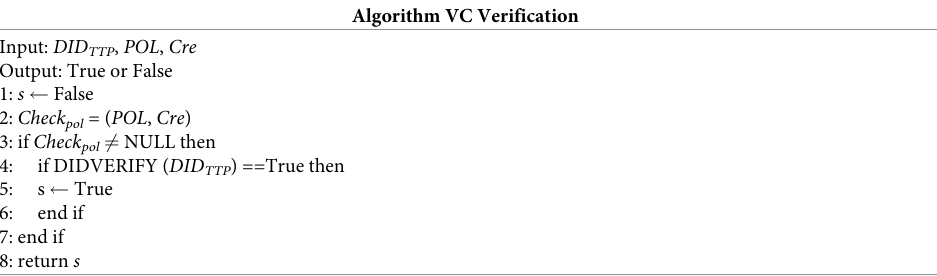
Table 5. Algorithm VC verification.